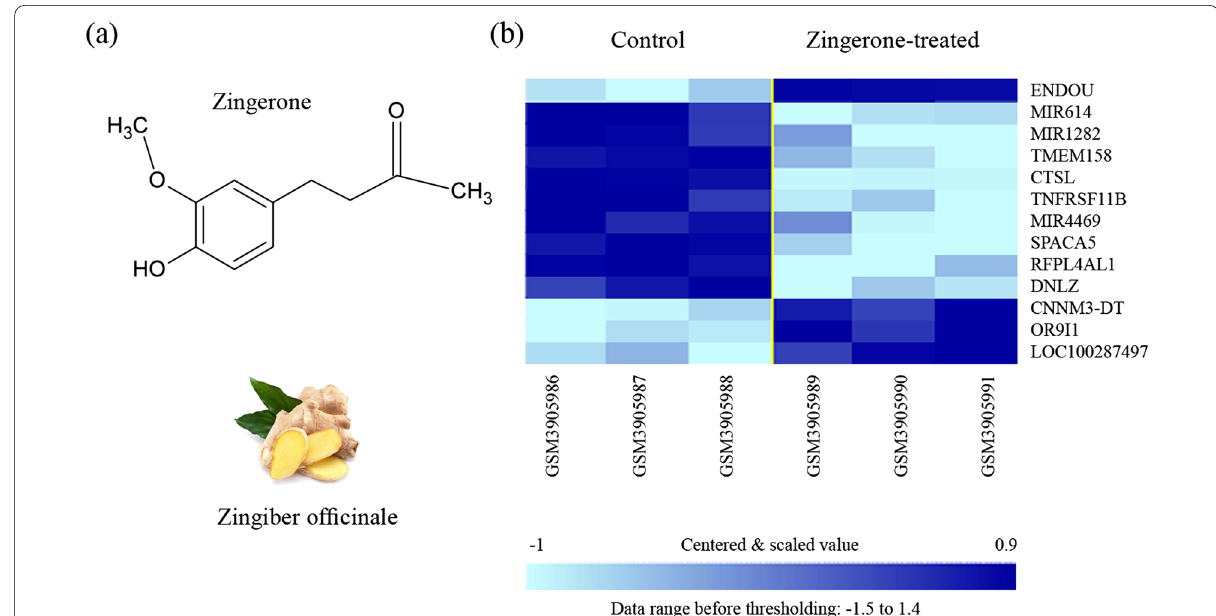
Fig. 2 a Chemical structure of zingerone [4-(4-hydroxy-3-methoxyphenyl) butan-2-one] as a zingiber constituent. b DEGs obtained from BRB-ArrayTools